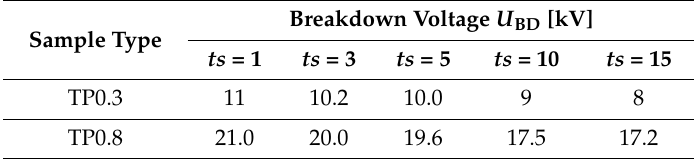
Figure 5. Twisted-pair samples with various number of twists ts . Table 1. Breakdown voltage U BD for samples TP0.3 and TP0.8 for a different number of twists ts.